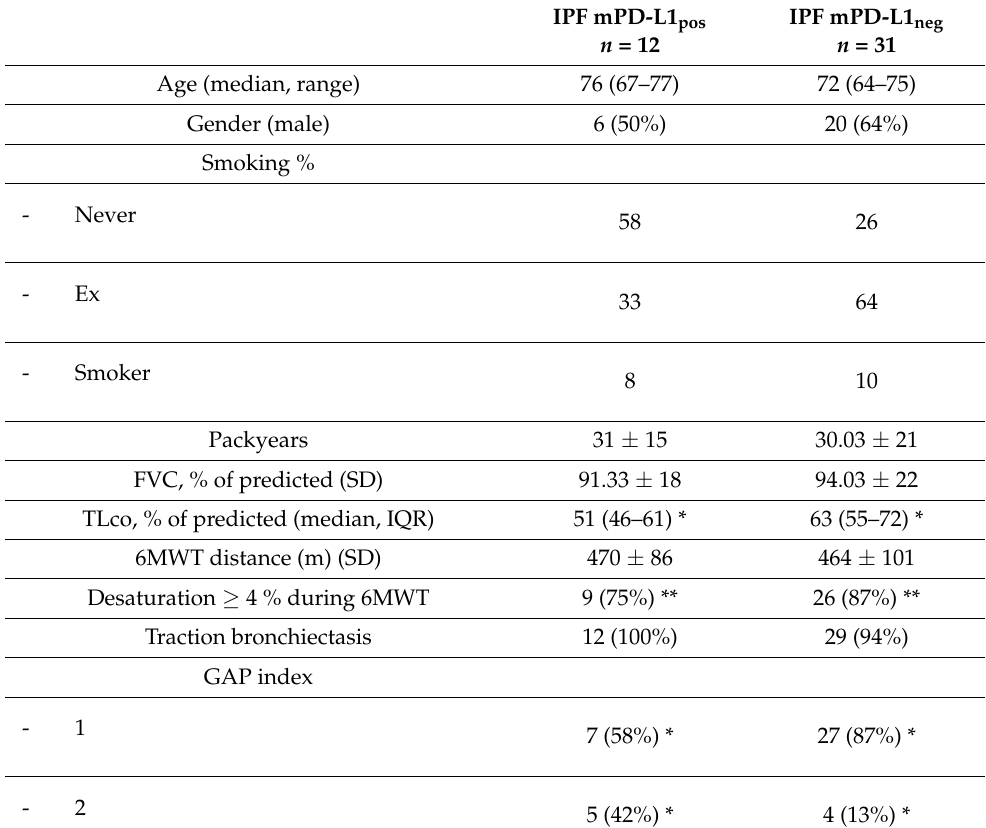
Table 4. Demographic characteristics of patients with IPF and PD-L1-positive and PD-L1-negative membrane